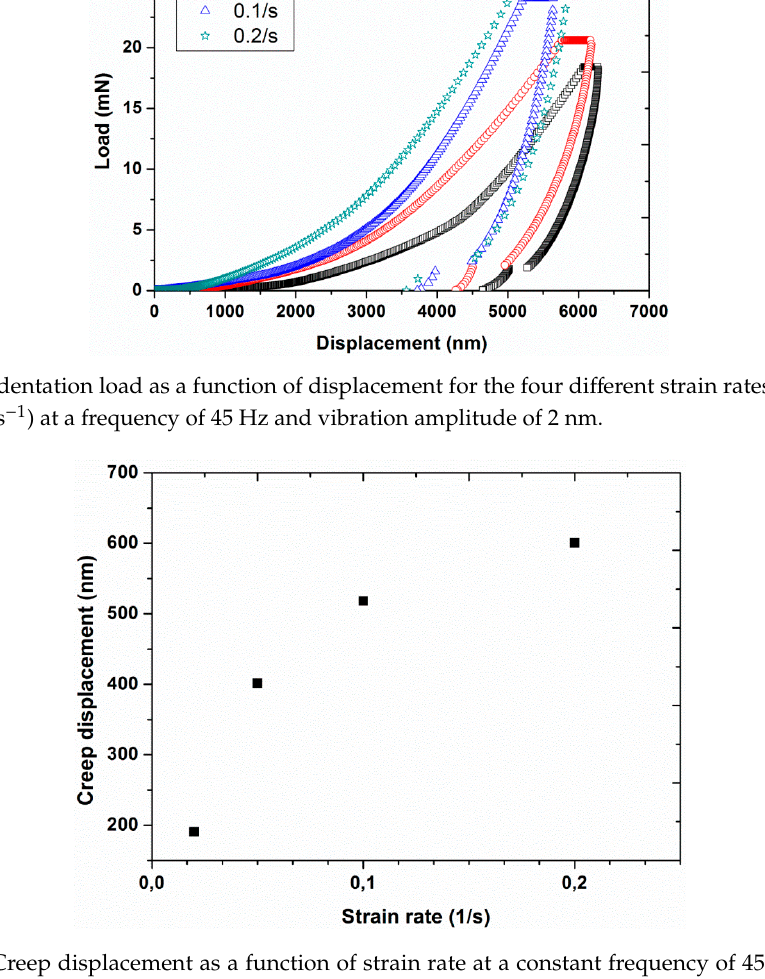
Figure 10. Creep displacement as a function of strain rate at a constant frequency of 45 Hz and an amplitude of 2 nm.